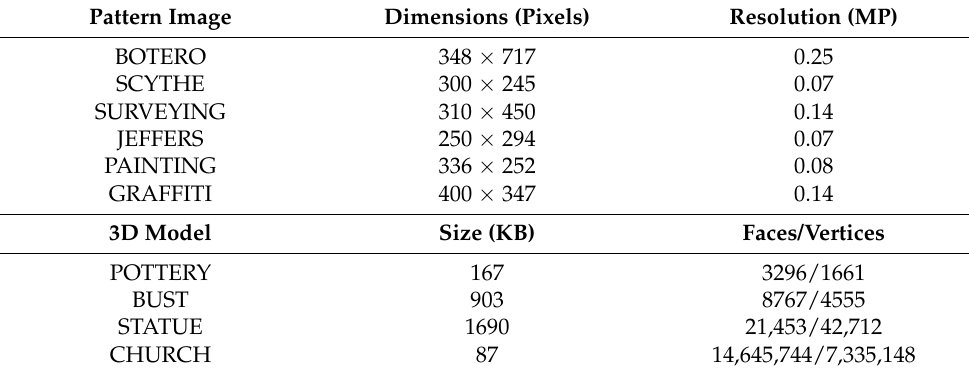
Table 3. Dimensions and resolution of the pattern images as well as size and number of faces and vertices of the 3D models used in the experiments.